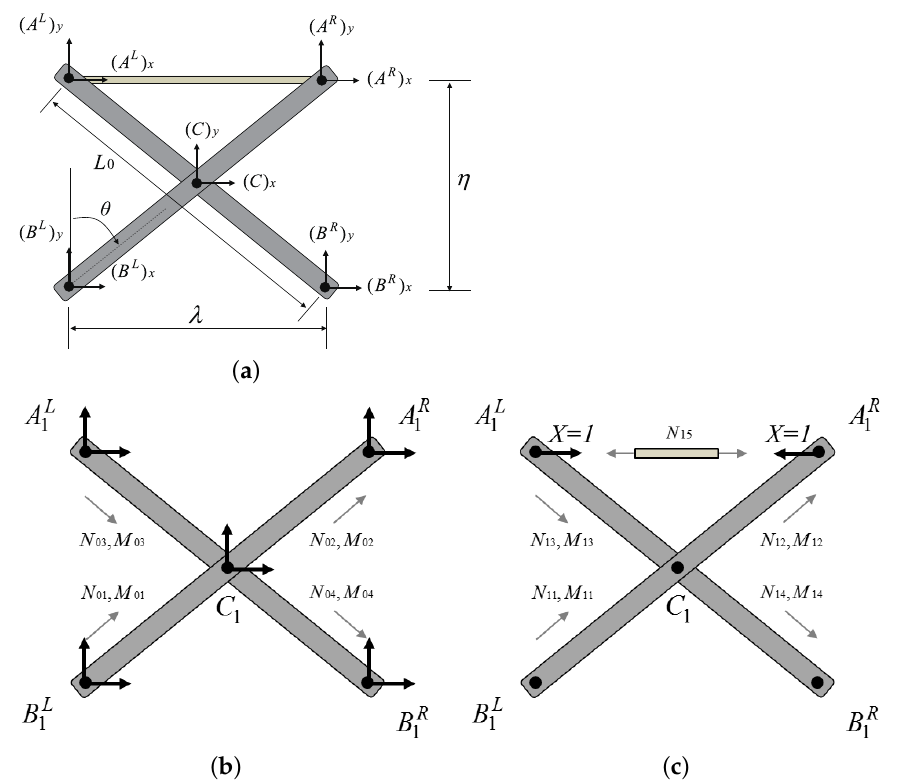
Figure 2. FBD of a scissor unit with a strut member: ( a ) original FBD; ( b ) basic model; ( c ) first